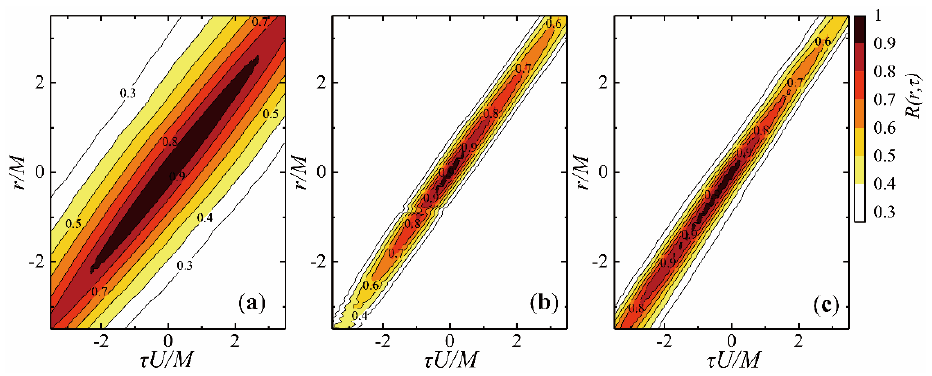
Figure 8. Space-time correlations of stream-wise velocities at mid-depth for ( a ) base flow; ( b ) x / M = 8 and ( c ) x / M = 18.